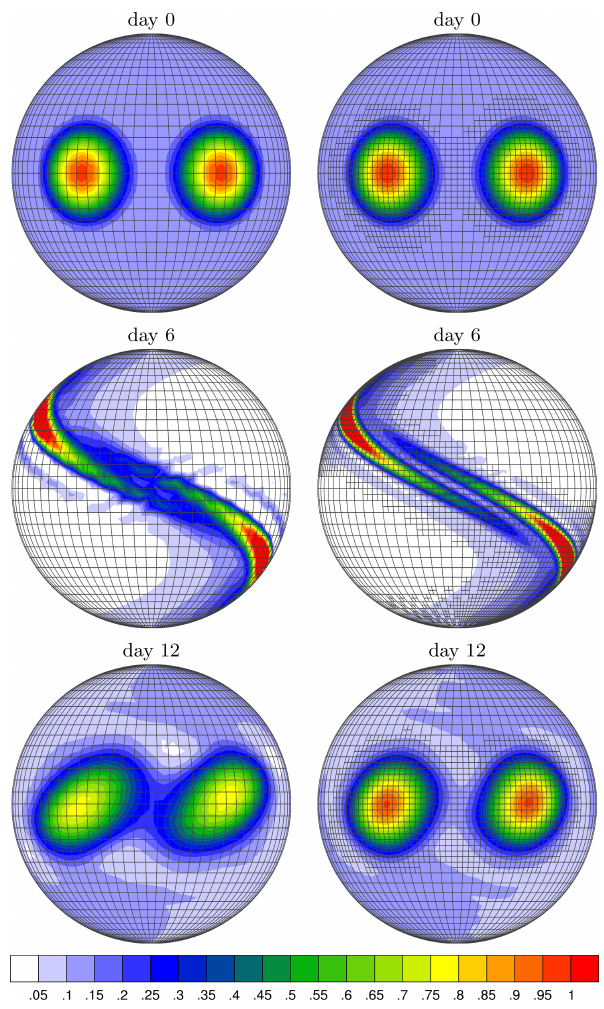
Figure 14. Numerical results of the divergence test case with a res- olution of 5 ◦ × 5 ◦ in the left panel and one-level refinement in the right panel. The maximum resolution is 2.5 ◦ × 2.5 ◦ . The Courant number is around